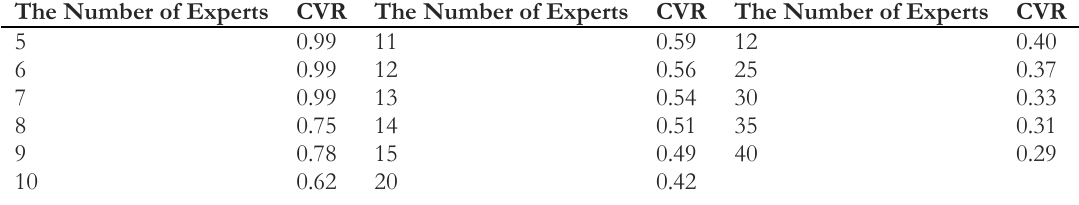
Table 1. The minimum acceptable CVR value based on the number of evaluating experts [45].